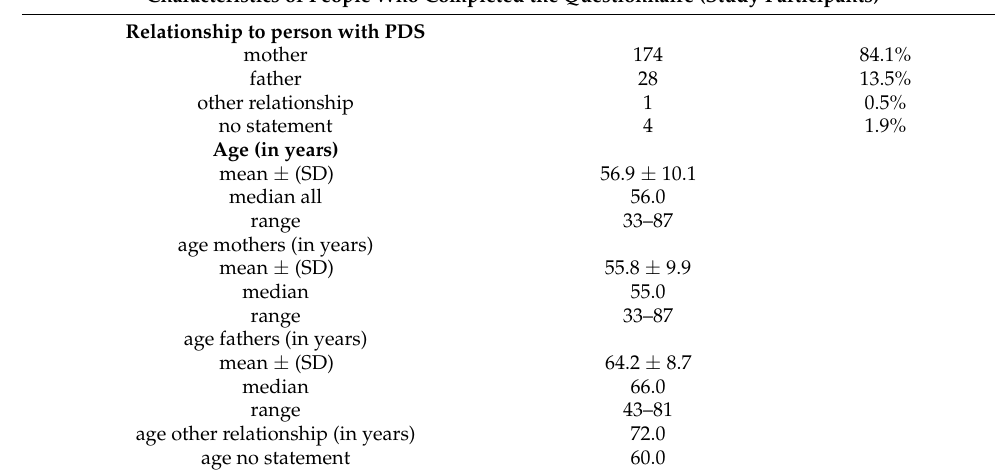
Table 1. Characteristics of the people who completed the questionnaire (family member/caregiver of the